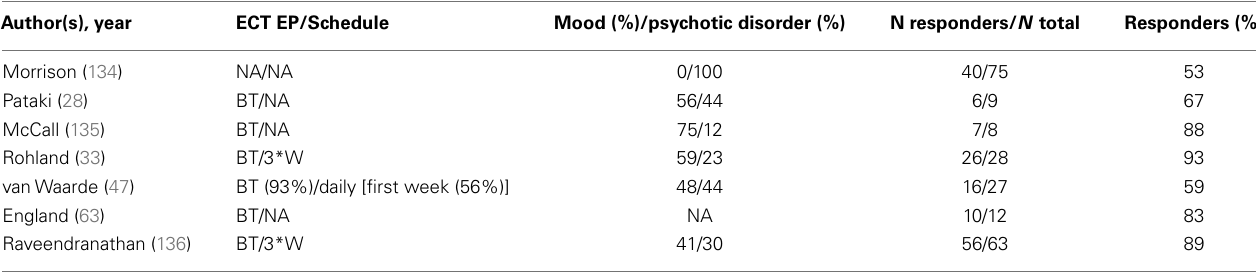
Table 1 | ECT in catatonia: retrospective chart reviews